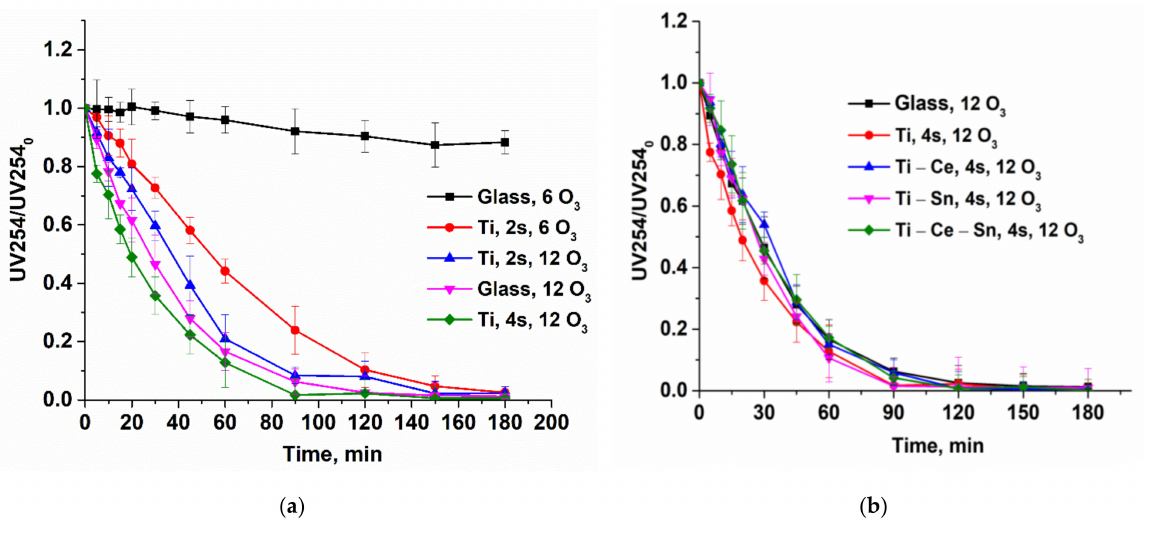
Figure 8. ( a ) Evolution of normalized UV254 parameter for (Ti) system in different reaction conditions; ( b ) Evolution of a normalized UV254 parameter for all prepared systems at a higher ozone input and four slides.